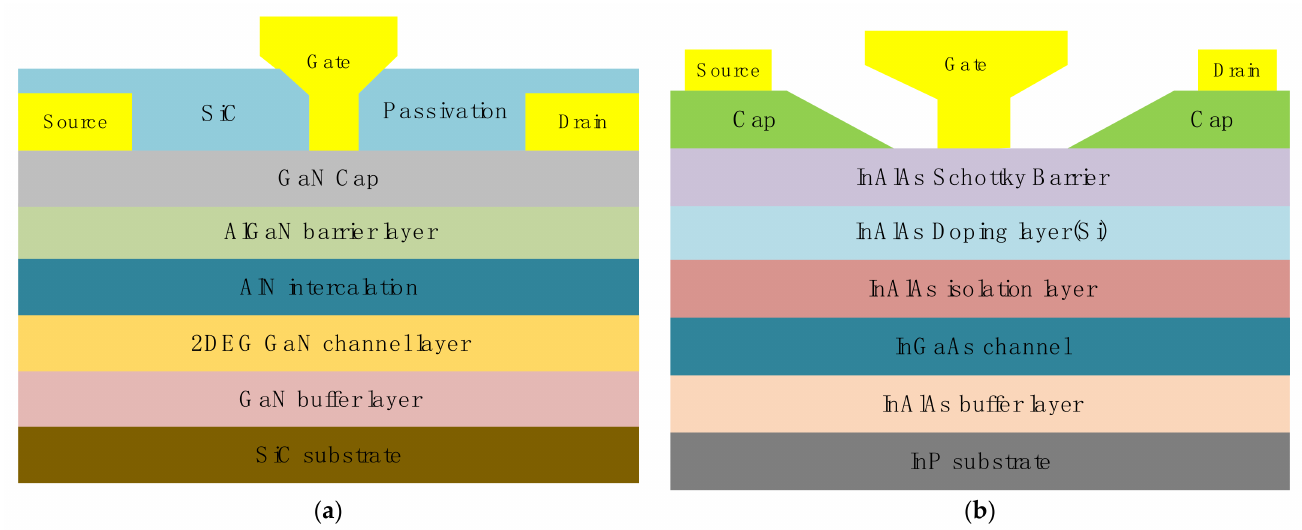
Figure 3. ( a ) GaN HEMT structure profile, ( b ) InP HEMT structure